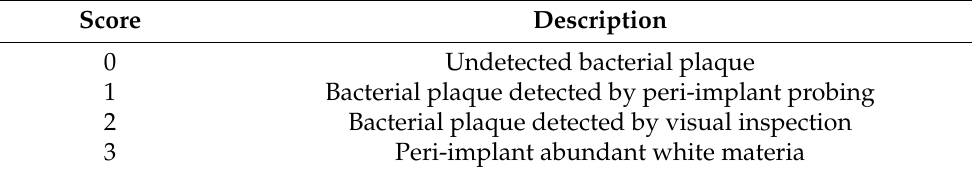
Table 4. mPI Indice (peri-implant bacterial plaque accumulation).